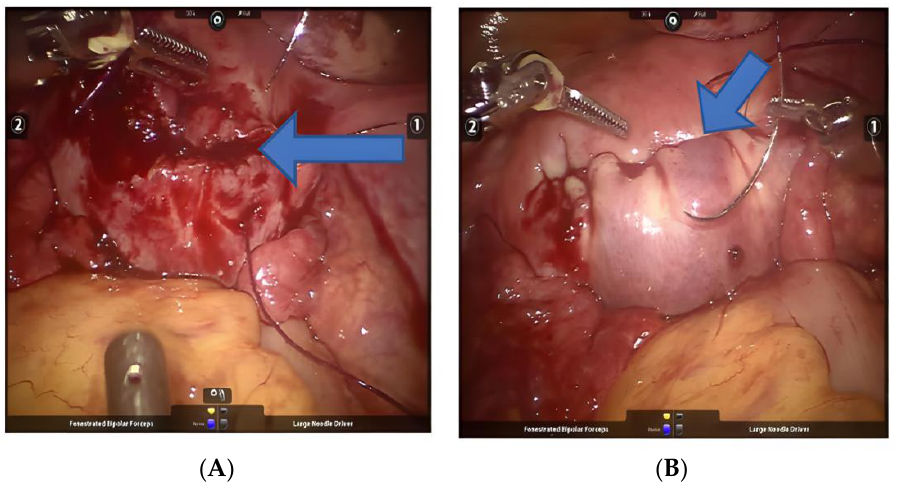
Figure 4. ( A ) The suture of the uterine wound. ( B ) 1-0 V-Loc absorbable barbed suture for continuous suture. Arrows point to suture direction.